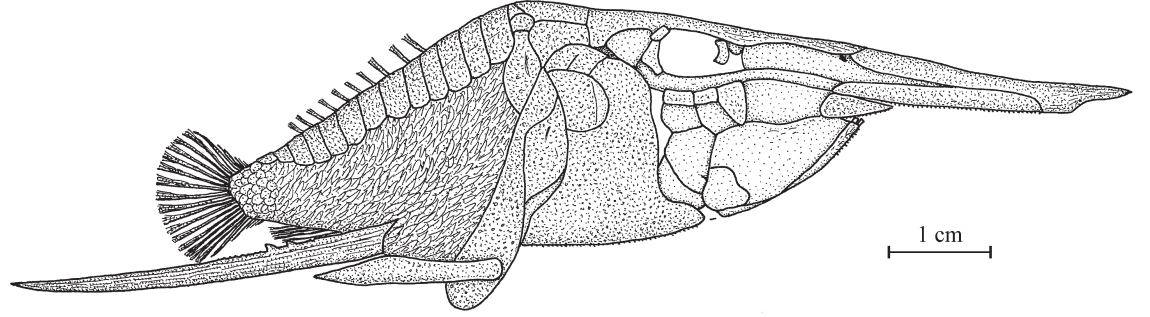
Fig. 2. Gladiopycnodus karami gen. et sp. nov. Reconstruction of holotype CLC